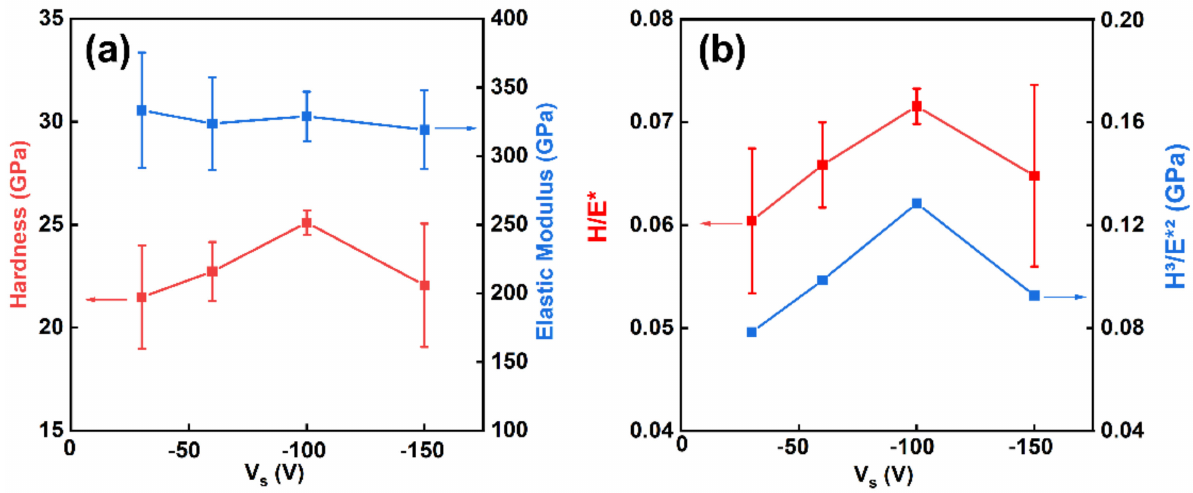
Figure 10. ( a ) Hardness and elastic modulus and ( b ) H / E * and H 3 / E * 2 ratio of coatings deposited at various V s